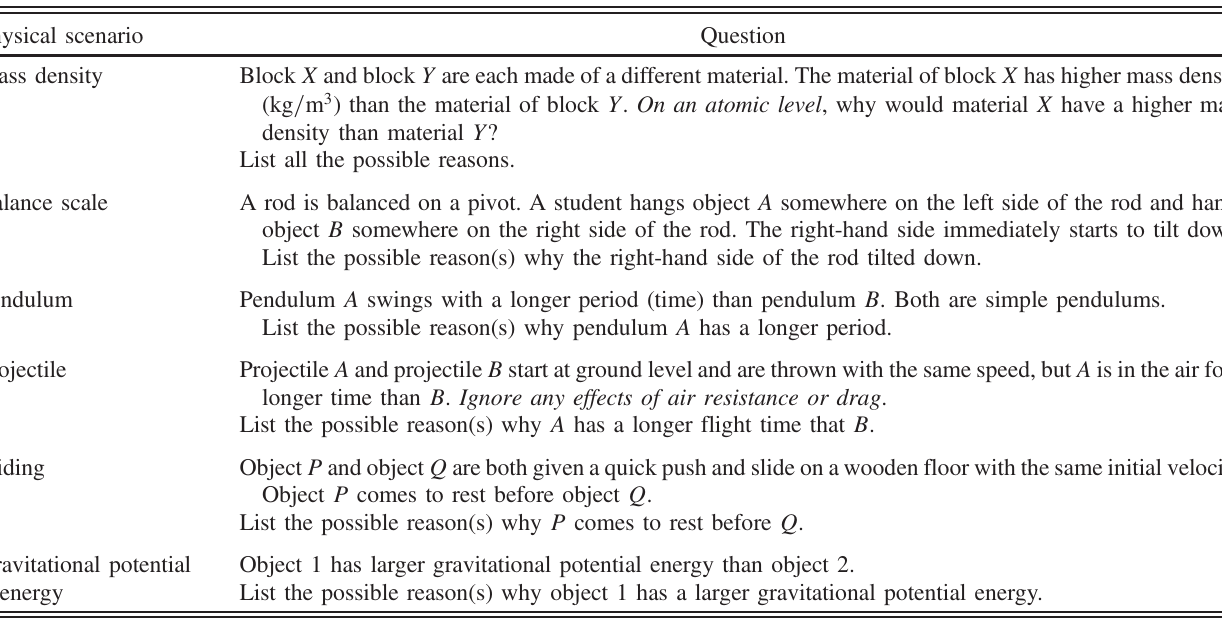
TABLE I. Experiment 1 recall condition questions. Physical scenario Mass